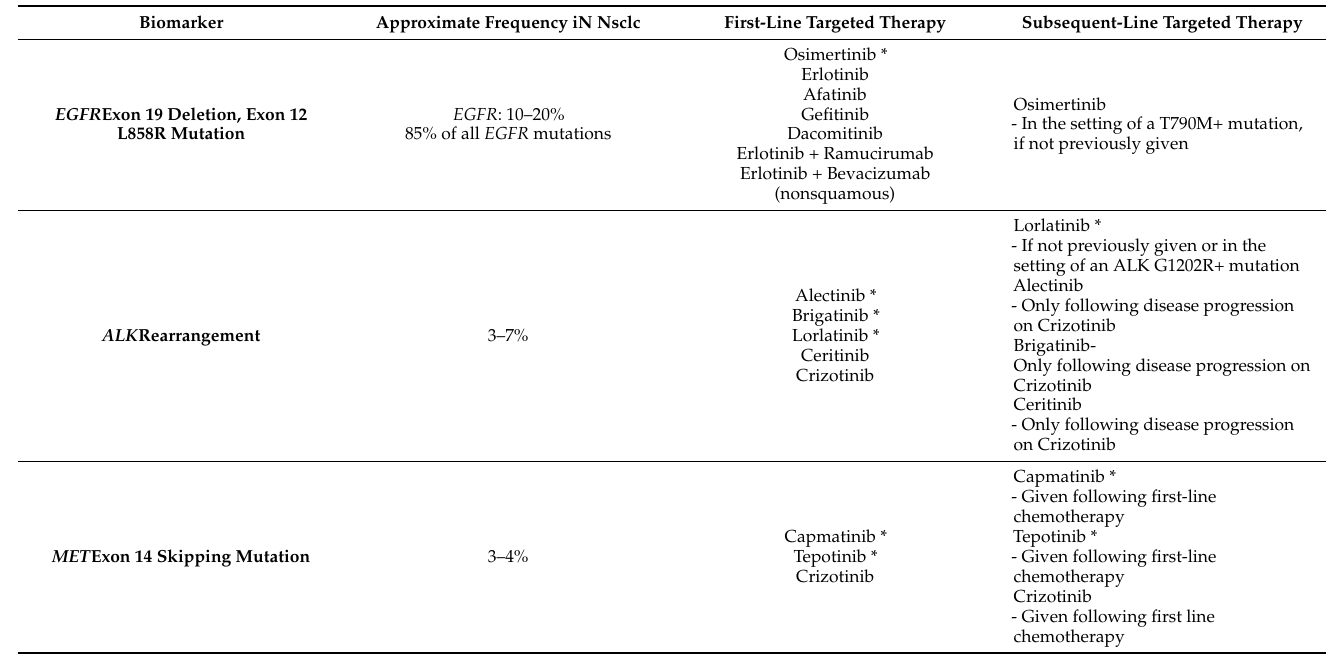
Table 1. Oncogenic driver mutations and respective first- and subsequent-line targeted therapies recommended by the NCCN [7–9]. * NCCN preferred